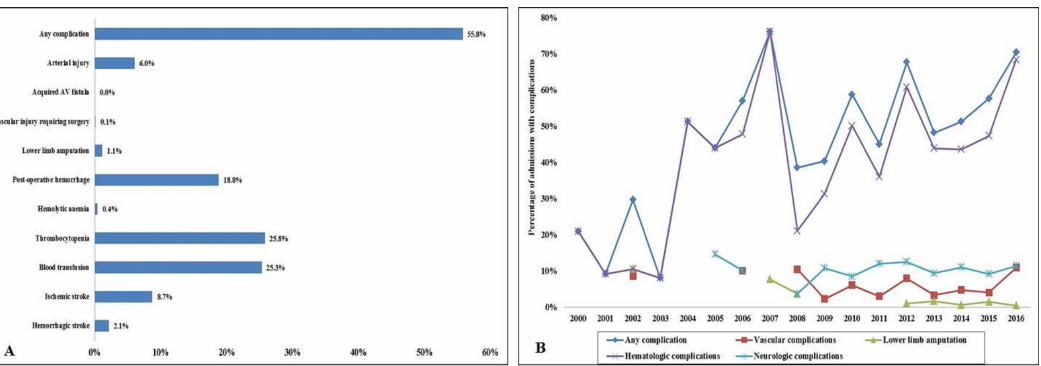
Figure 1. Complications in acute myocardial infarction admissions supported by extracorporeal membrane oxygenation. ( A ) Relative percentages of in-hospital complications across the various complication categories; ( B ): 17-year temporal trends of in-hospital complications; p < 0.001 for trend. AV: arterio-venous.